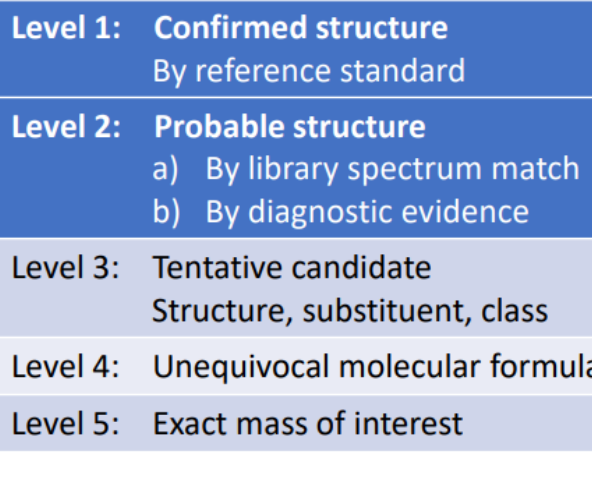
Figure 7. Proposed identification confidence levels in high resolution mass spectrometric analysis.